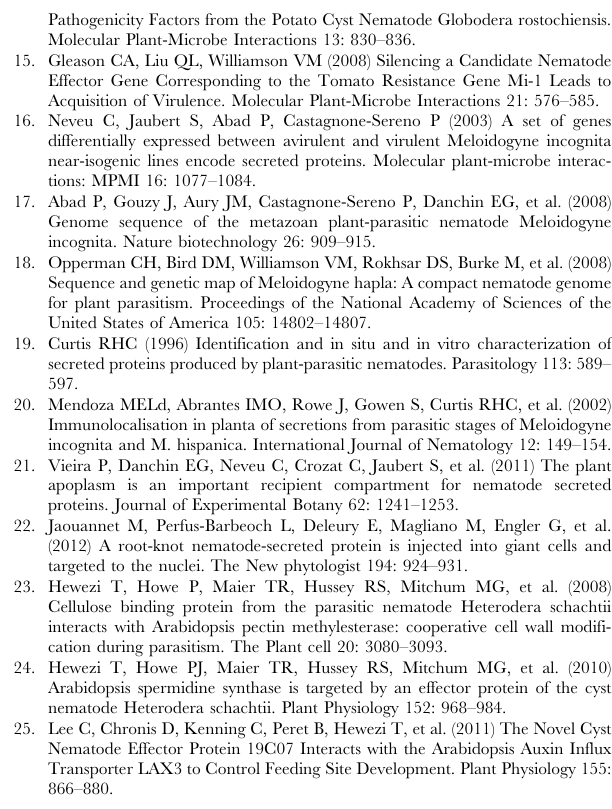
Table S1 Transcript-derived fragments sequences. Table S2 Summary of the 63 transcript-derived frag- ments (TDF) a . a Differential expression between ARE- and H 2 O-treated Meloidogyne incognita infective juveniles b Presence (Y) or absence (N) of signal peptide (SP) was determined by using SignalP software. When no full cDNA or protein sequence was available, the presence of a SP was not determined (Na). c Putative